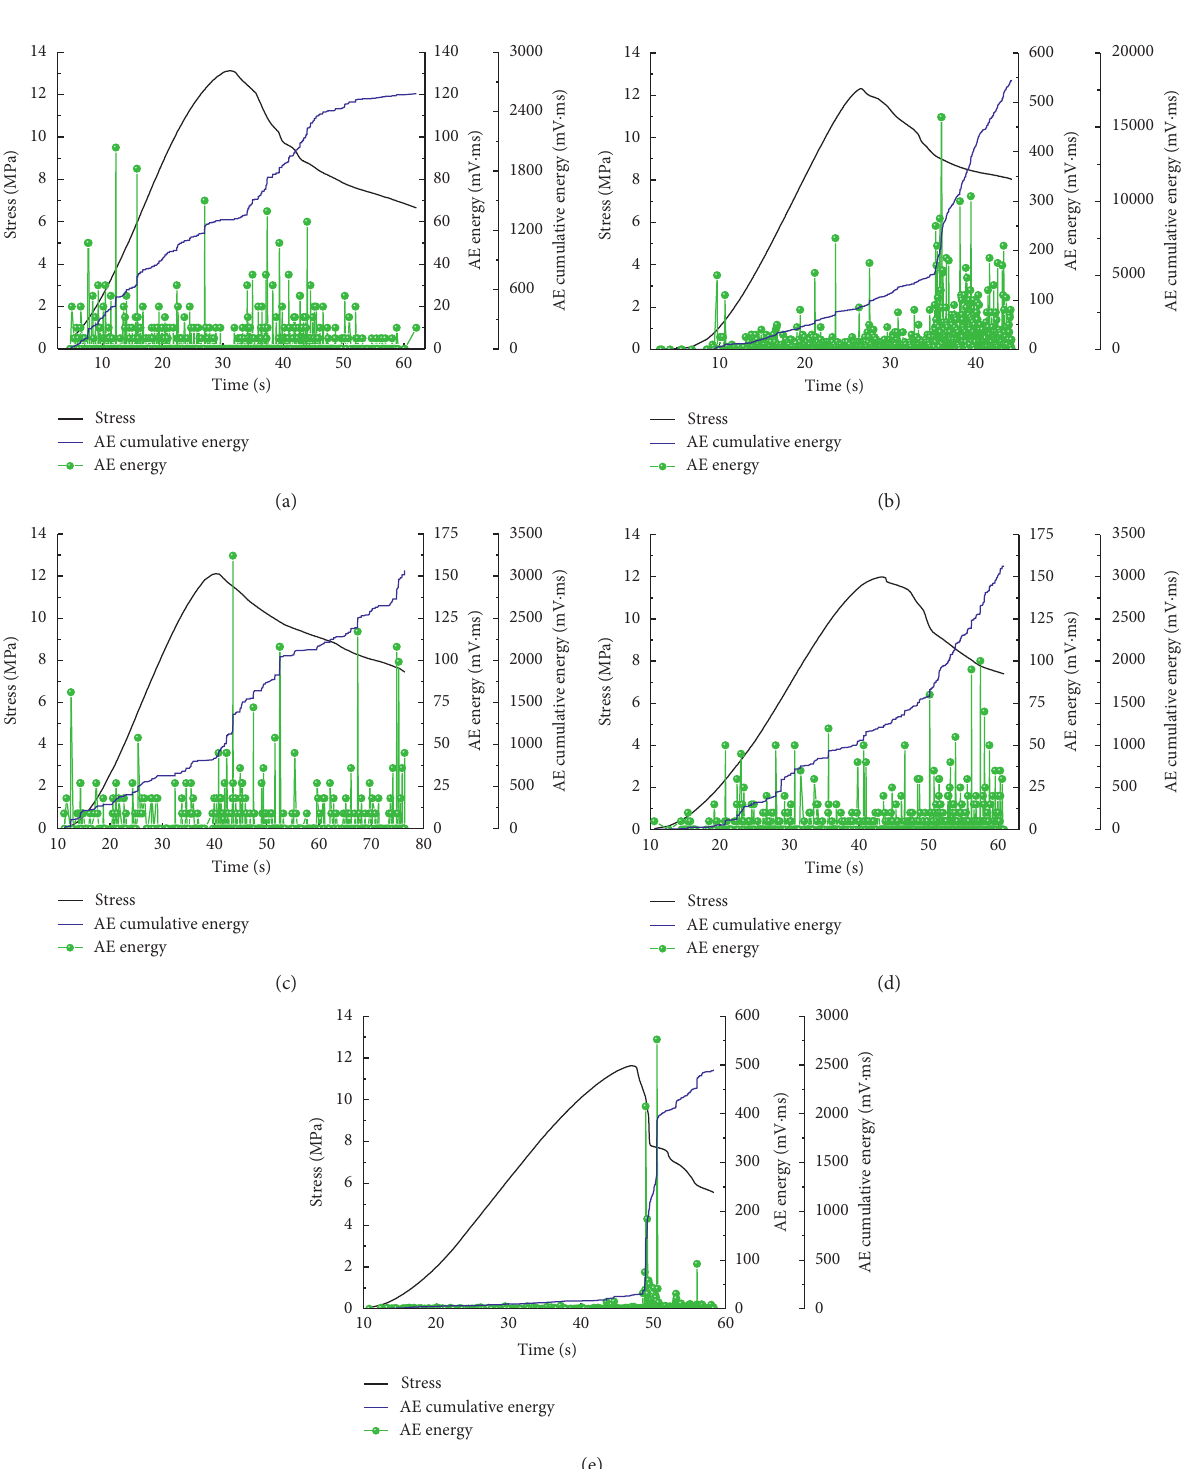
Figure 7: Typical curve of stress-time-AE energy evolution of coal-like material samples under different borehole arrangements. (a) Scheme I 03: complete samples. (b) Scheme II 02: samples with boreholes. (c) Scheme III 02: samples with borehole with stepwise increased borehole depth. (d) Scheme IV 01: samples with borehole with stepwise increased borehole diameter. (e) Scheme V 03: samples with borehole with stepwise increased borehole depth and borehole